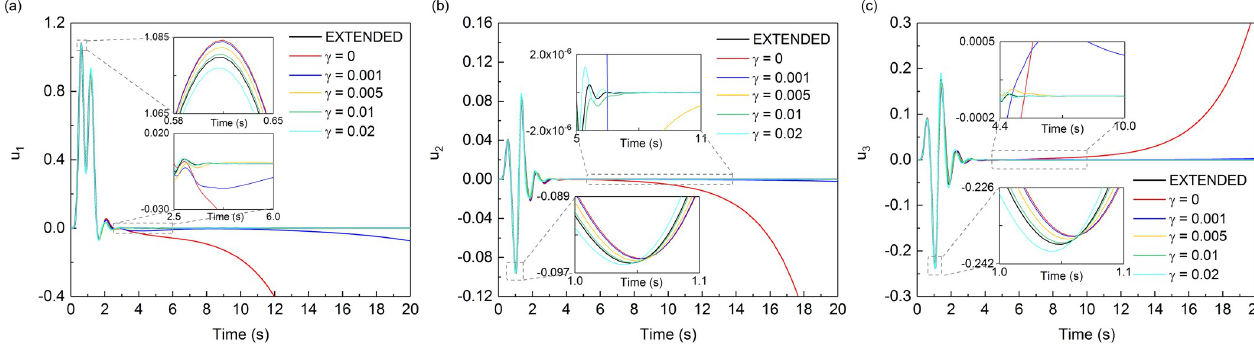
Fig 10. Displacement time-histories of observation point A